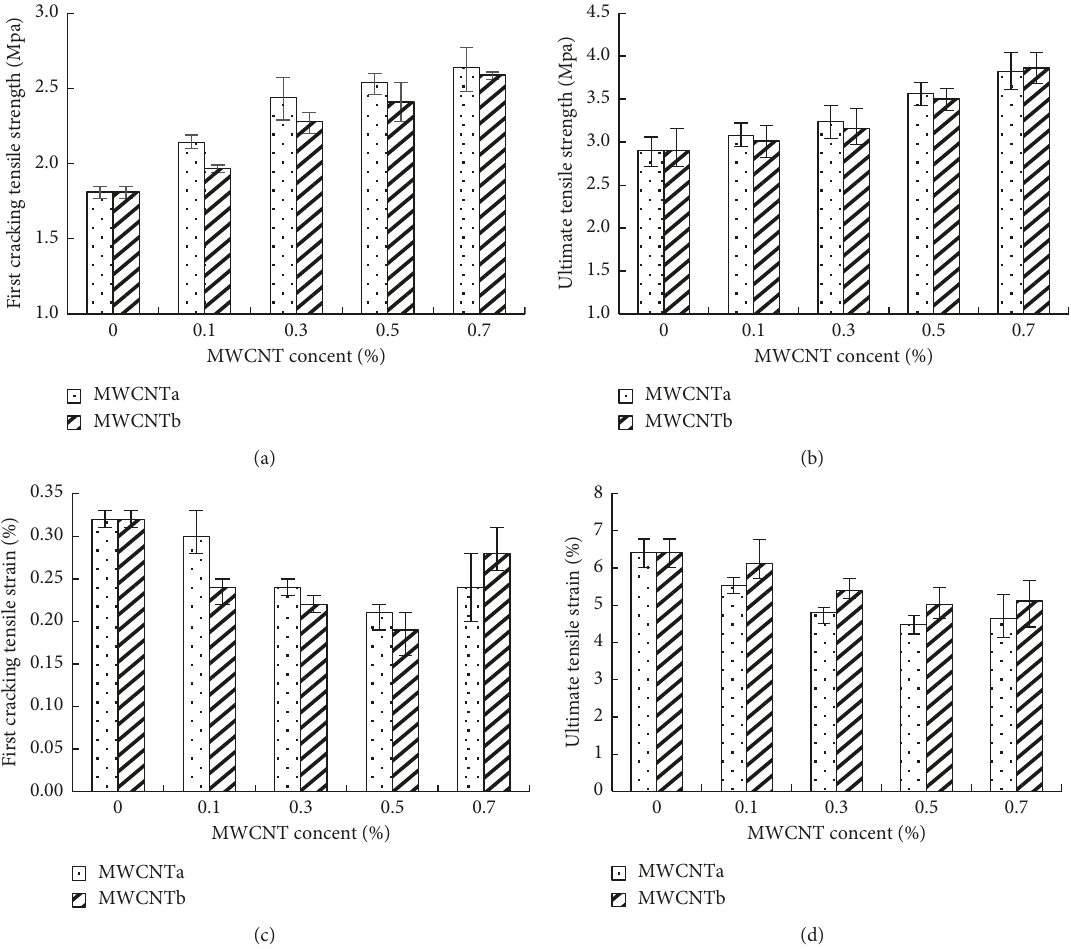
Figure 5: Characteristics of stress-strain curves of the uniaxial tensile test for MWCNT-reinforced ECCs. (a) First cracking tensile strength. (b) Ultimate tensile strength. (c) First cracking tensile strain. (d) Ultimate tensile